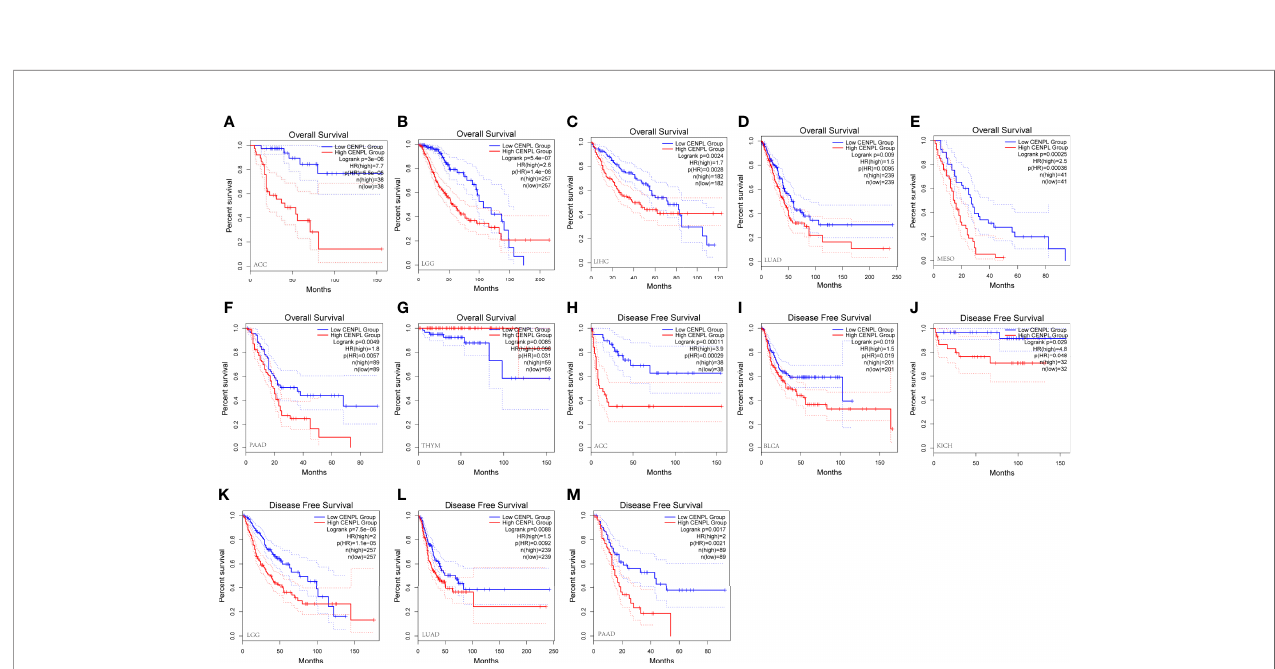
FIGURE 3 | The prognosis value of CENPL in pan-cancer. (A – G) Kaplan – Meier analysis of the association between CENPL expression and OS. (H – M) Kaplan – Meier analysis of the association between CENPL expression and